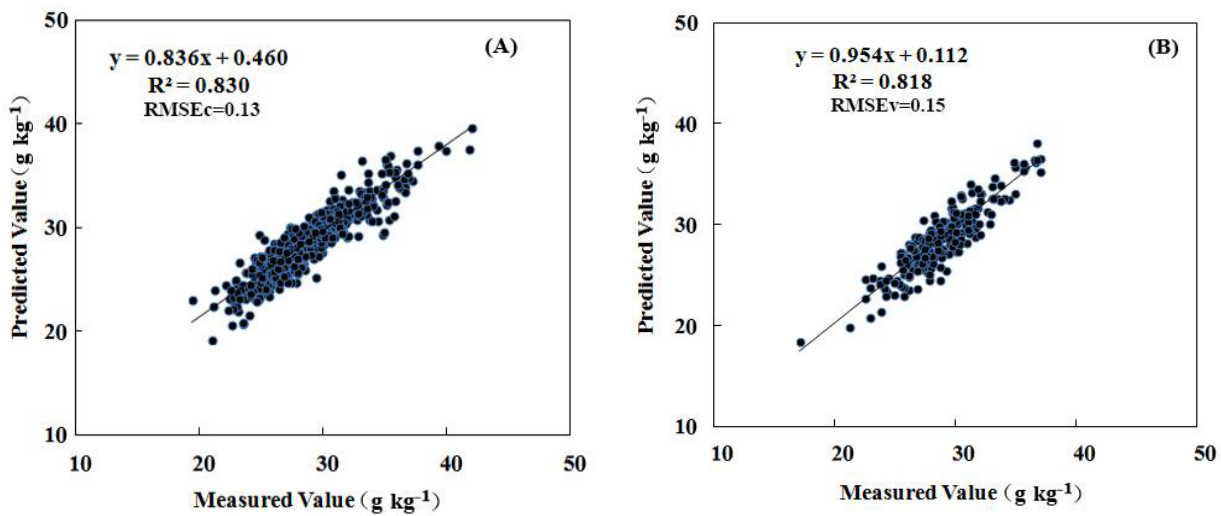
Figure 3. Measured vs. predicted N concentration. ( A ) calibration of model (n = 780). ( B ) validation of model (n = 230). The lines were defined using partial least squares (PLS) regression.